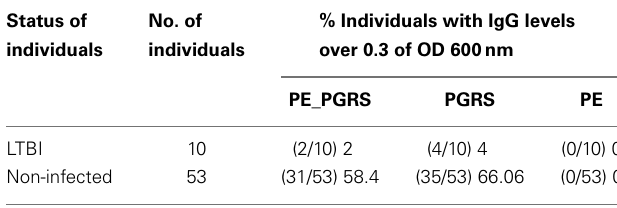
Table 2 | IgG levels against PE_PGRS33 and their PGRS and PE domains detected by ELISA in LTBI and non-infected individuals